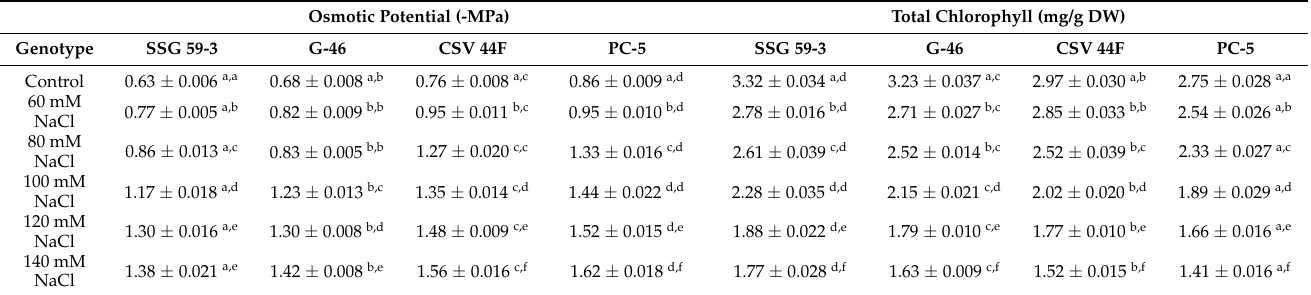
Table 4. The physiological indices of sorghum seedlings under saline conditions.